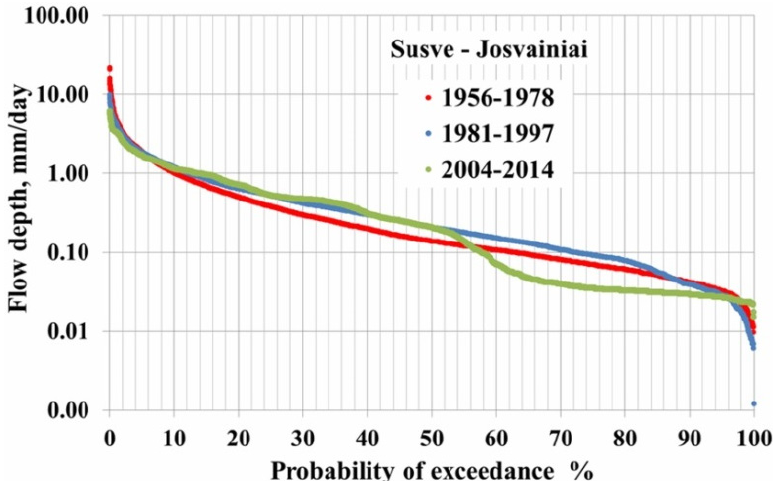
Figure 6. Comparison of FDCs of different periods at Josvainiai GS.